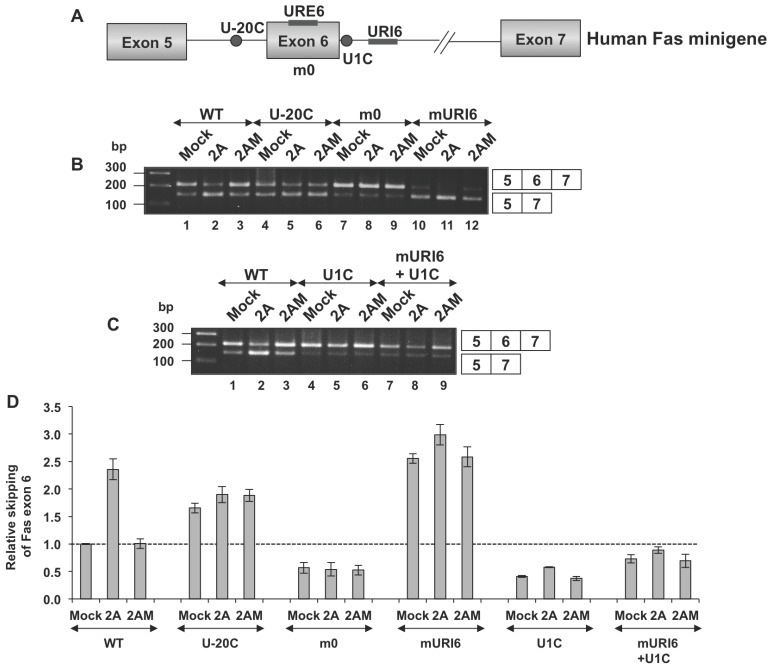
The URE6 sequence mediates skipping of Fas exon 6 in 2Apro-expressing cells.(A) Schematic diagram of the human Fas minigene (Fas genomic sequence from exon 5–7) and mutations used (Izquierdo, 2010). (B and C) Huh7-T7 cells were transfected with, pTM1-2A or pTM1-2AM or empty (mock) plasmid and analyzed as in Figure 1B. (D) Intensity of the bands from panels B and C was calculated by densitometry and the values of ratios between 5–7 and 5–6–7 amplification products were expressed as mean ± s.d. (n = 2). The dotted line indicates the ratio of the control sample.